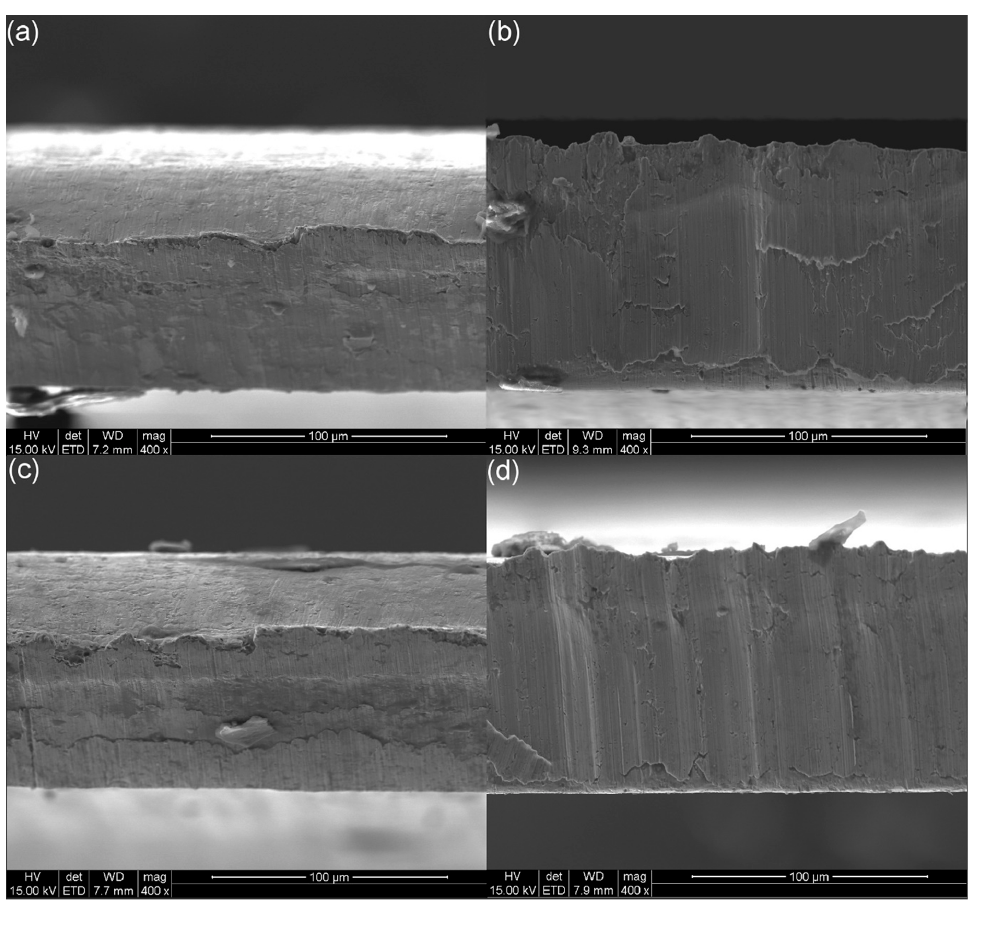
Figure 8. Cross sections of the steel sheets being cut depending on the localization of the observed surface: top sheet ( a ) and ( b ) and bottom sheet ( c ) and ( d ) at the back side of the cutting tool ( a ) and ( c ) and at the front side of the cutting tool ( b ) and ( d ) mag. 400×.